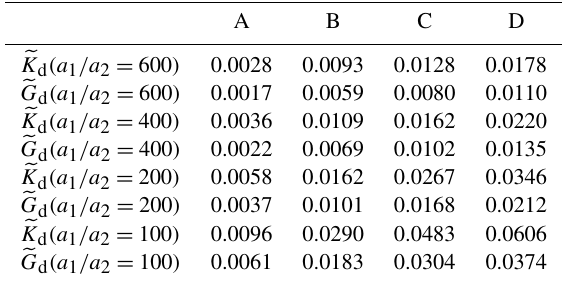
Table 3. Intrinsic bulk and shear moduli for the fractures for litholo- gies A–D and for variable aspect ratios, given with units